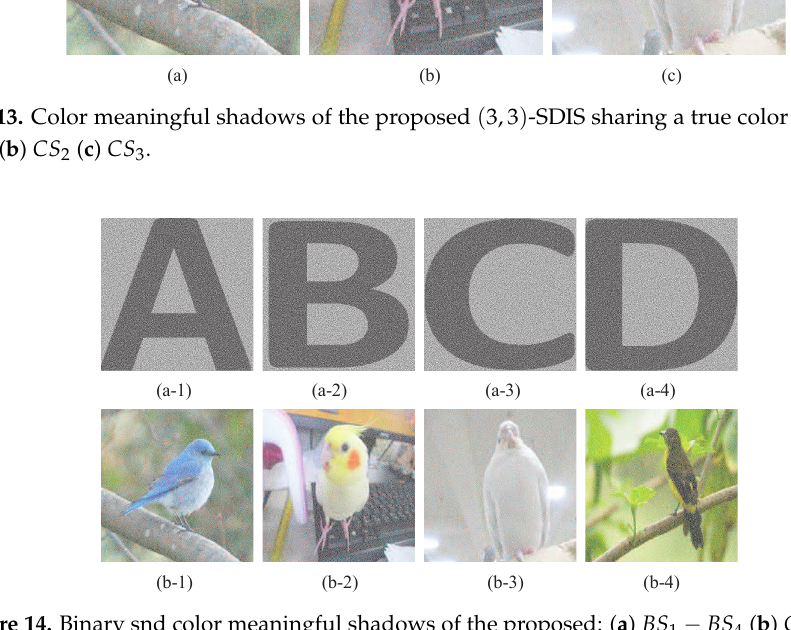
Figure 14. Binary snd color meaningful shadows of the proposed: ( a ) BS 1 − BS 4 ( b ) CS 1 − CS 4